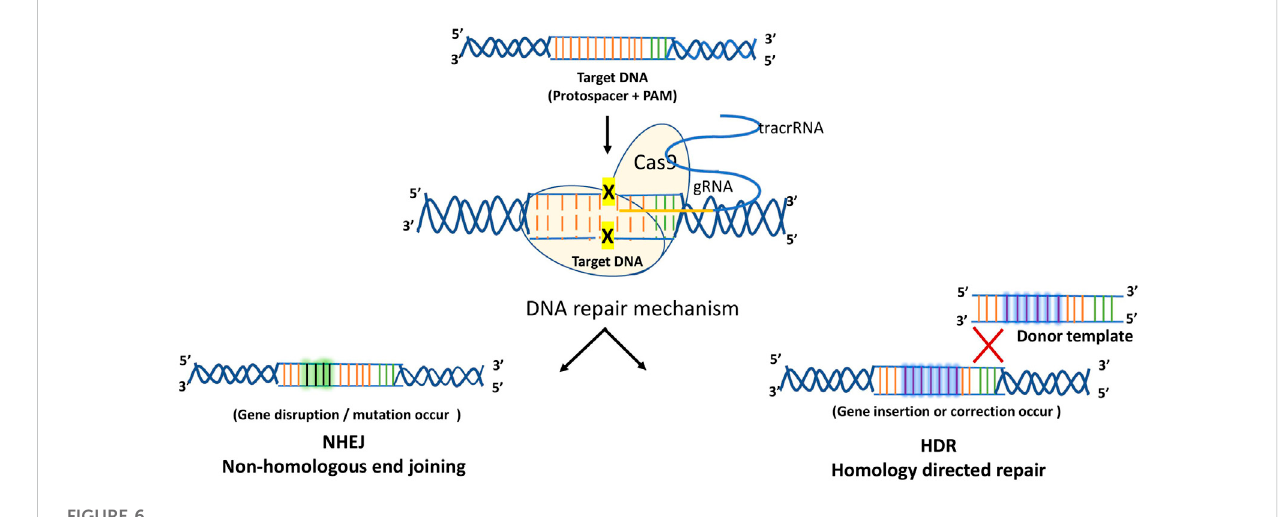
FIGURE 6 Generalized mechanism of CRISPR/Cas-9.